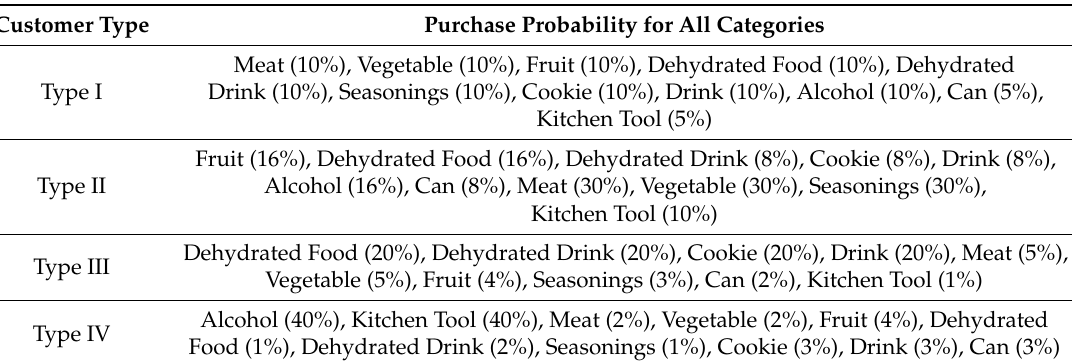
Table 2. Simulated purchase dataset. T_ID